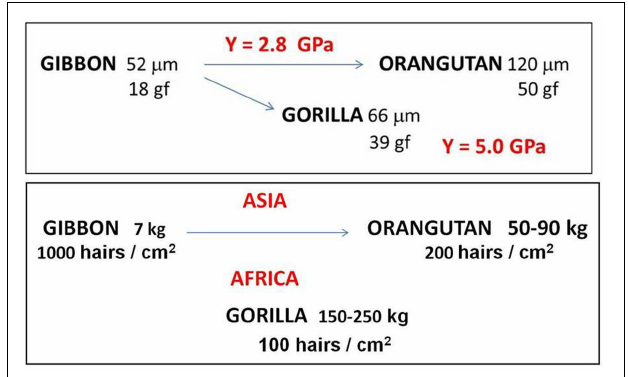
FIGURE 5 | Sketch of evolution among Hominoidea: upper focusing the Young modulus, down the species location. See text for complete explanation.